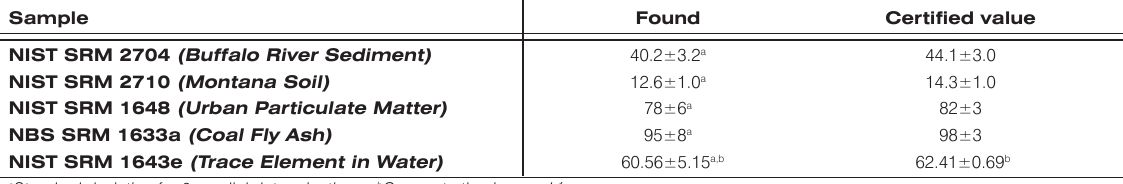
Table 4. Determination of nickel (concentration in μg g -1 ± SD) in certified reference materials using CVG-IAT-FAAS technique (continuous-flow system).